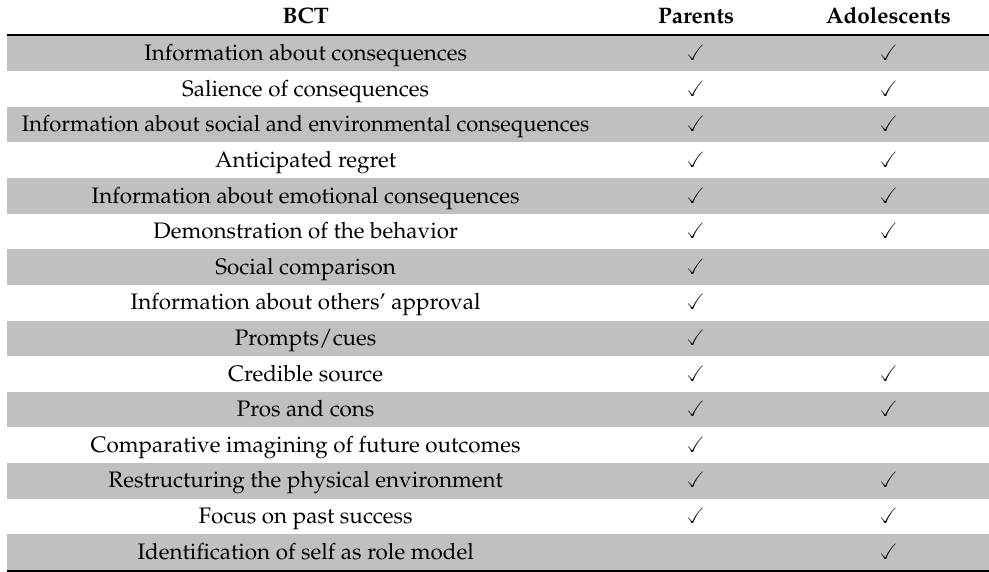
Table 2. Summary of Behaviour Change Techniques (BCT) identified in parents and adolescents through previous qualitative